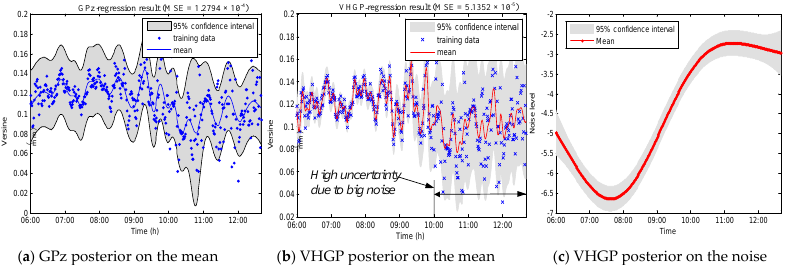
Figure 7. Data with the train-induced noise for VHGP training.